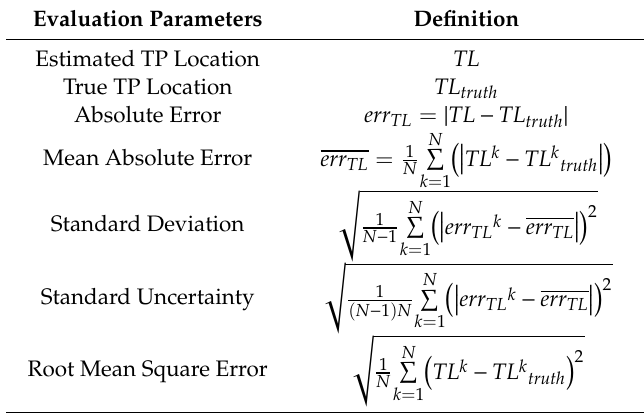
Table 2. Definition of evaluation parameters.